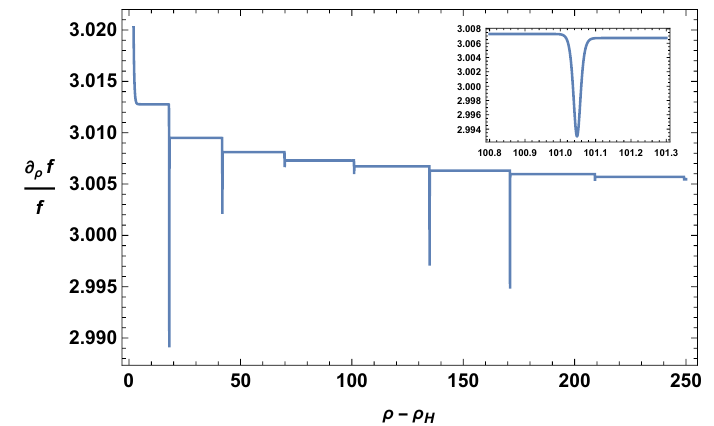
Figure 2: The metric slowly approaches the Schwarzschild singularity behaviour ∂ / f = 3 at late interior times, through a sequence of Kasner epochs. The sharp ρ f dips in ∂ ρ f / f at the transitions between epochs are not spurious. The inset zooms in on one of the